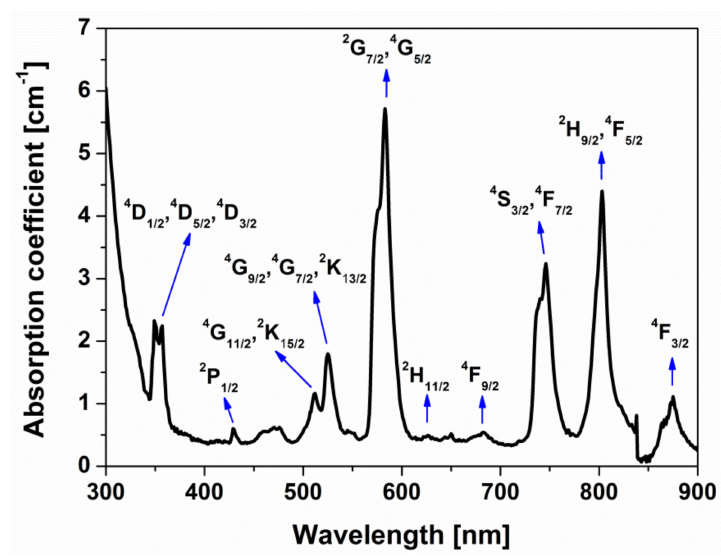
Figure 3. Absorption spectrum of the Nd-doped phosphate glass. The main Nd 3 + levels are labeled, considering absorption from the ground state 4 I 9 / 2 .